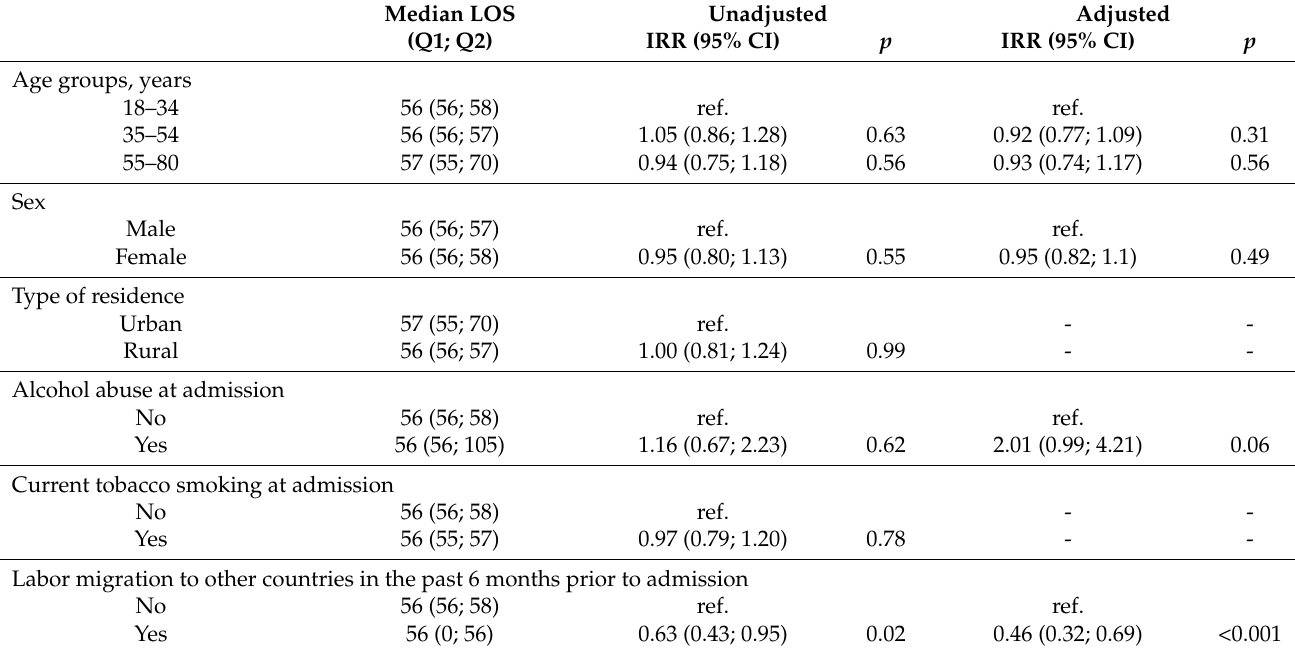
Table 2. Factors associated with the total length of stay among patients with UGTB who received first-line treatment, Tashkent, Uzbekistan, 2016–2018 (N =